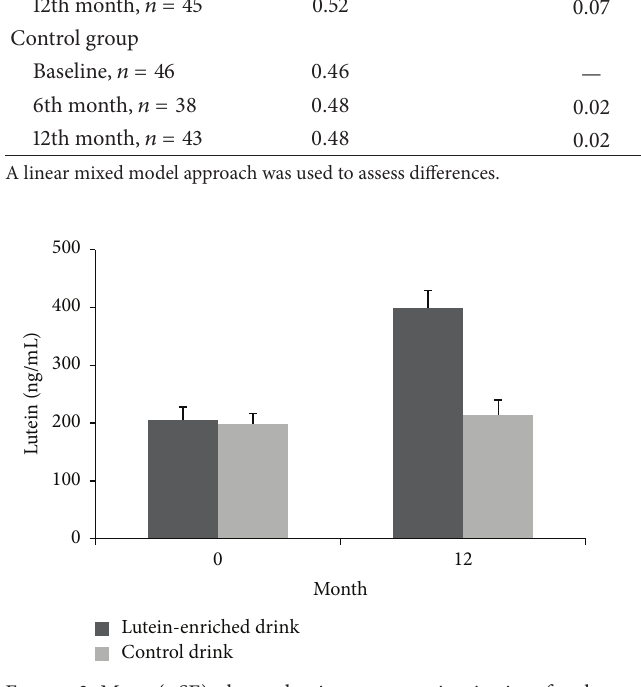
Figure 3: Mean ( ± SE) plasma lutein concentration in time for the lutein group (dark grey) and the placebo group (light grey). The increase in the lutein group was significantly different from the change in the control group ( 𝑃 < 0.001 ).